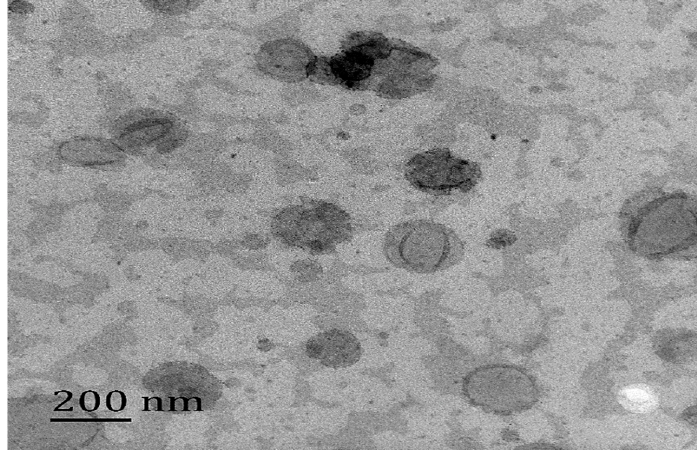
Figure 4. The physical appearance and particle diameter of C3G nanoliosomes.